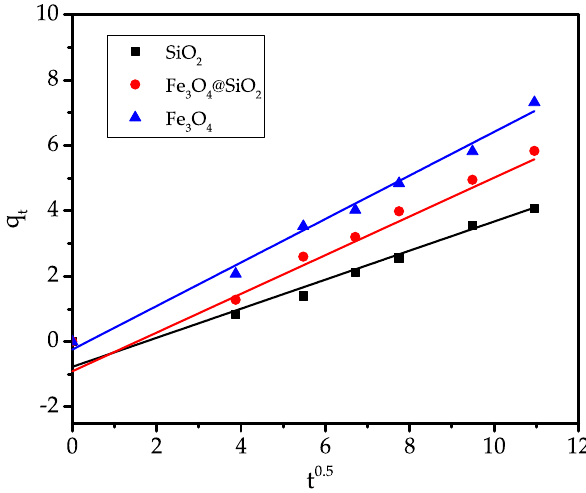
Figure 8: Intra - particle di ff usion plots of RhB adsorption by Fe 3 O 4 @SiO 2 , SiO 2 , and Fe 3 O 4